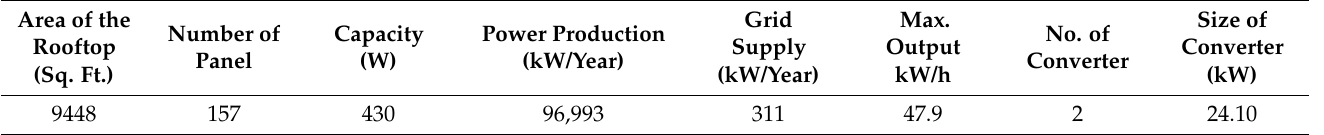
Table 8. Summary of upscaling the PV sizing and possible power output obtained from Helioscope simulation